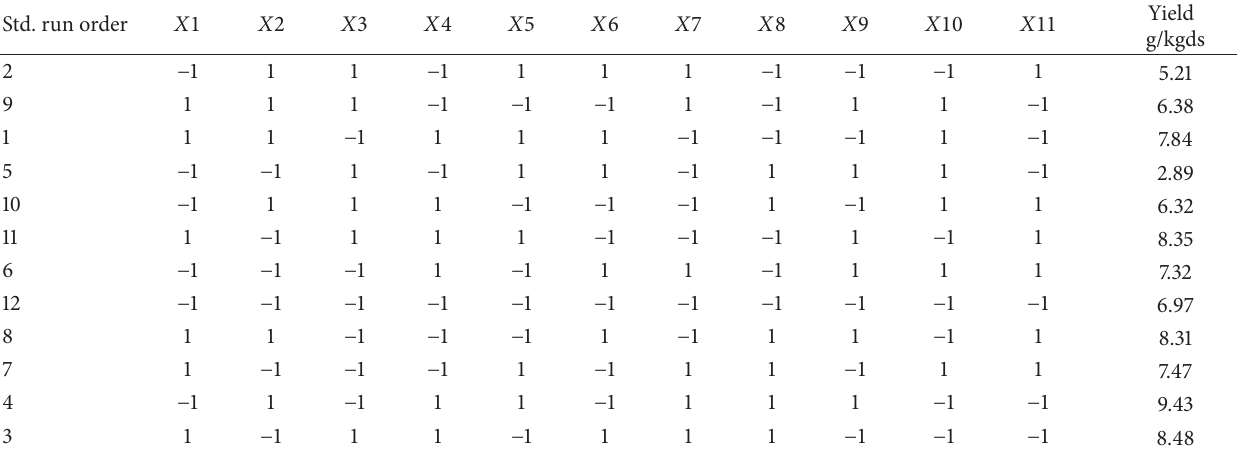
Table 2: Yield of rifamycin B from Nocardia mediterranei MTCC 14 using the different levels of production variables of Plackett-Burman design test.